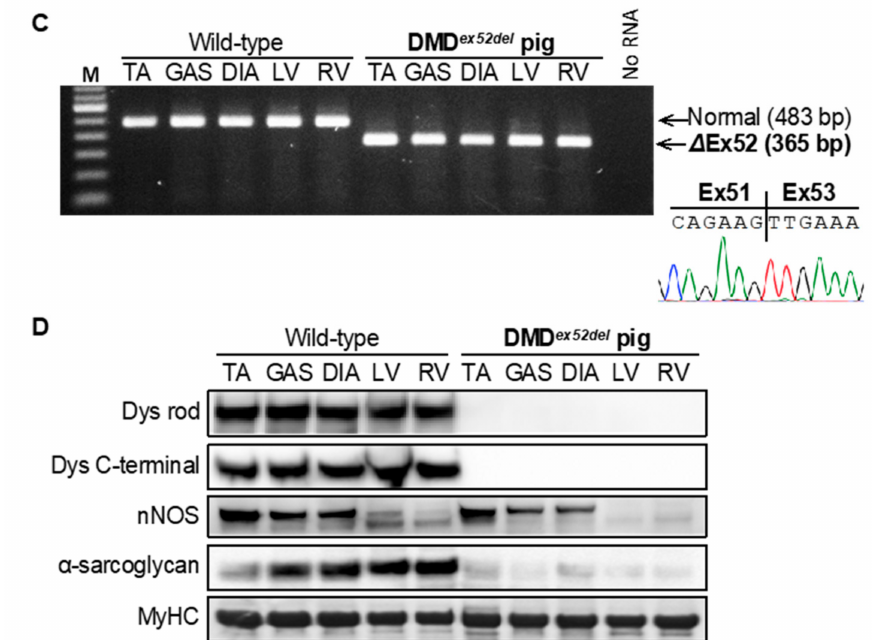
Figure 2. Molecular characterization of the DMD exon 52-deleted miniature pig model. ( A ) Genotyp- ing PCR using umbilical cord tissue lysates confirmed the exon 52 deletion in the pig DMD gene. Lanes 1–5 represent PCR amplicons of the DMD region of DMD ex52del pigs. Lane 6 is a lysate from a wild-type pig. ( B ) Representative genomic Southern blot of 3 DMD ex52del pigs. (Left) MfeI-digested genomic DNA was hybridized with a probe that detects porcine DMD downstream of the target- ing vector boundary. The DMD -targeted allele produced an approximately 6.3 kb band, and the wild-type band is 4.7 kb. (Right) The same DNA was hybridized with a probe that detects the Neo R , yielding only the targeted 6.3 kb band. Lane 1: wild-type; Lanes 2–4: individual DMD ex52del male pigs. ( C ) RT-PCR revealed exon 52-deletion in DMD mRNA in the skeletal and cardiac muscles. TA, tibialis anterior; GAS, gastrocnemius; DIA, diaphragm; LV, left ventricular free wall; RV, right ventricular free wall. ( D ) Lack of dystrophin and reduction in its associated protein levels in skeletal and cardiac muscles as represented by Western blotting. Dystrophin (Dys) rod domain and Dys C-terminal were detected by monoclonal antibodies, NCL-DYS1 and NCL-DYS2, respectively. nNOS, Neuronal nitric oxide synthase. MyHC, myosin heavy chain stained by Coomassie Brilliant Blue in a post-transferred